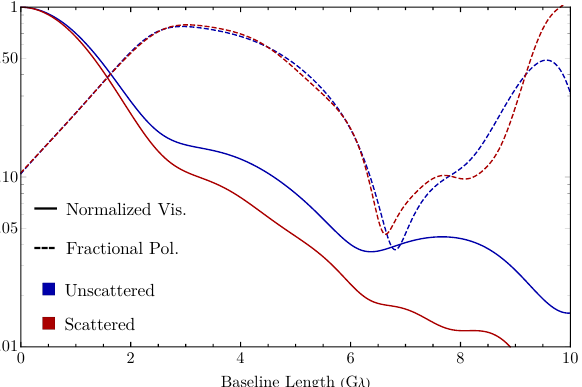
Figure 7. Interferometric properties of the GRMHD model shown in Figure 6. Solid lines show the (cid:12) (cid:12) normalized intensity (cid:12) ˜ I ( u ) /˜ I ( 0 ) (cid:12) before (blue) and after (red) scattering, and the dashed lines show the interferometric fractional polarization magnitude | ˘ m ( u ) | . For these curves, baselines are oriented along the East–West direction: u = ( u ,0 ) . Over the full range of baseline lengths accessible from the ground, the fractional polarization is largely immune to scattering, while diffractive scattering causes a substantial reduction in the flux on long